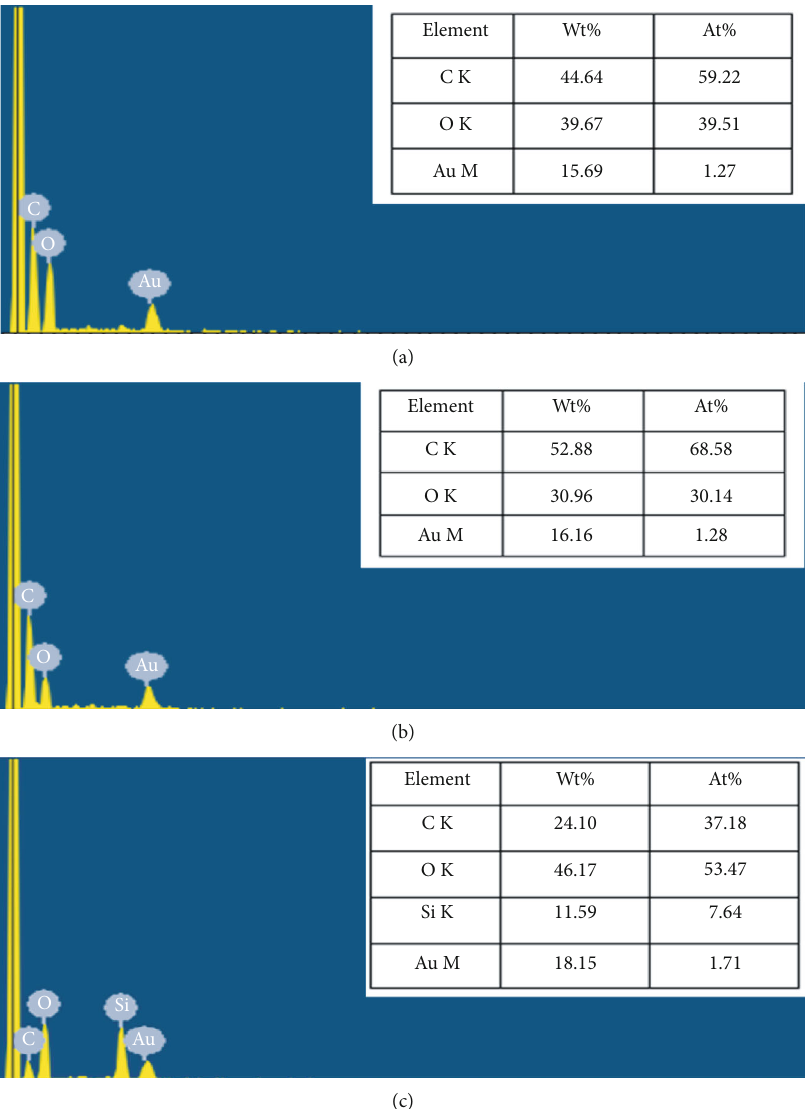
Figure 2: EDX spectra and element contents of BT (a), RGOBT (b), and RGO@SiO